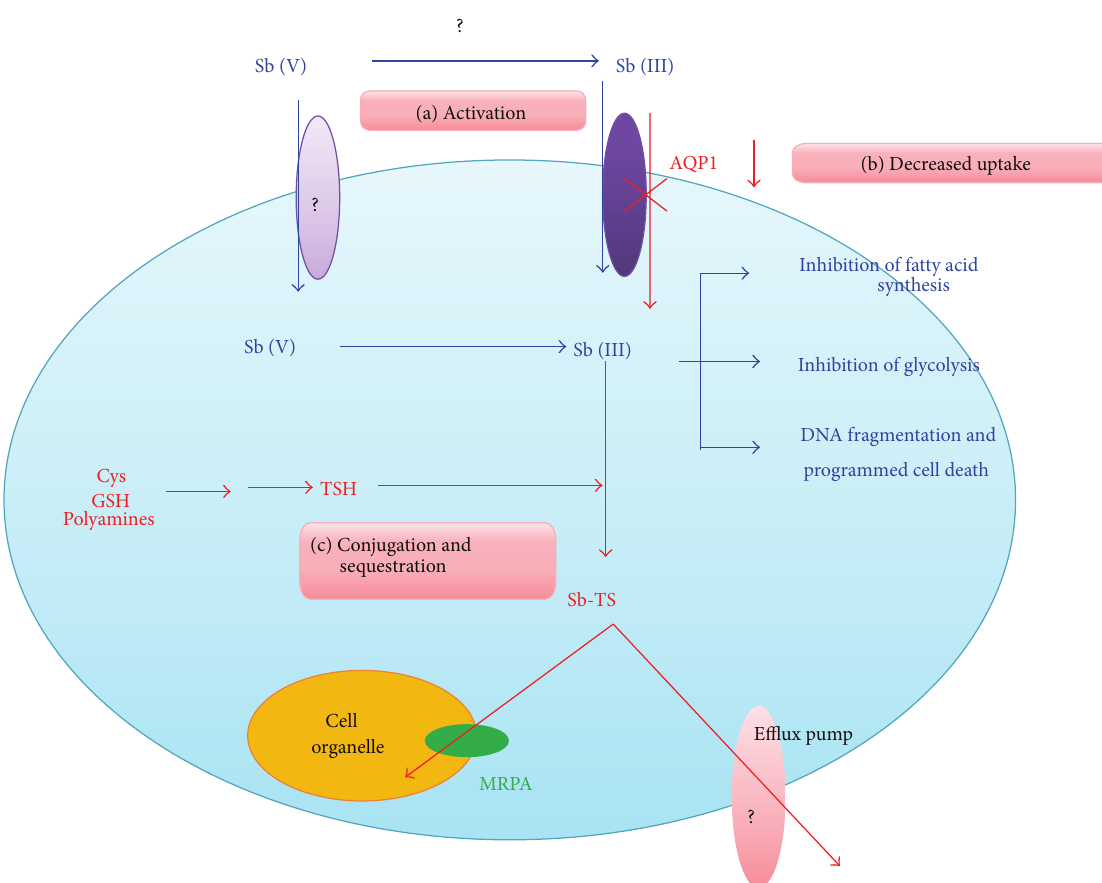
Figure 1: The mechanisms of antimony resistance in Leishmania . (a) Activation: conversion of Sb (V) to Sb (III) is inhibited in R-cells. This inhibition can either occur extracellularly (by inactivation of enzymes still unknown) or intracellularly (by inhibition of enzymes like ACR2 or TDR1). (b) Decreased uptake: decreased expression of AQP1 reduces Sb uptake into the cell thus conferring resistance. (c) Conjugation and sequestration: increased thiol levels (like cysteine (Cys), GSH, TSH, and polyamines) in the cell result in its conjugation with antimony to form antimony-thiol complex (Sb-TS) which then results in sequestration of the complex into a cell organelle or extrusion from the cell thus lowering intracellular amount of antimony. Blue lines indicate the probable drug action in sensitive Leishmania strains while red lines depict the probable routes to achieve resistance as observed in resistant